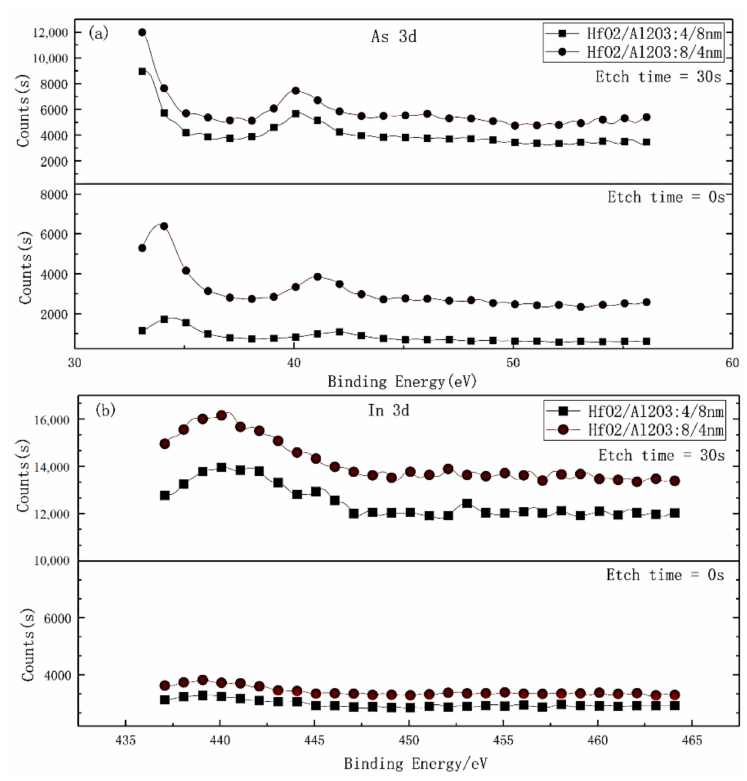
Figure 4. XPS spectra before and after etching for 30 s: ( a ) As 3 d ; ( b ) In 3 d